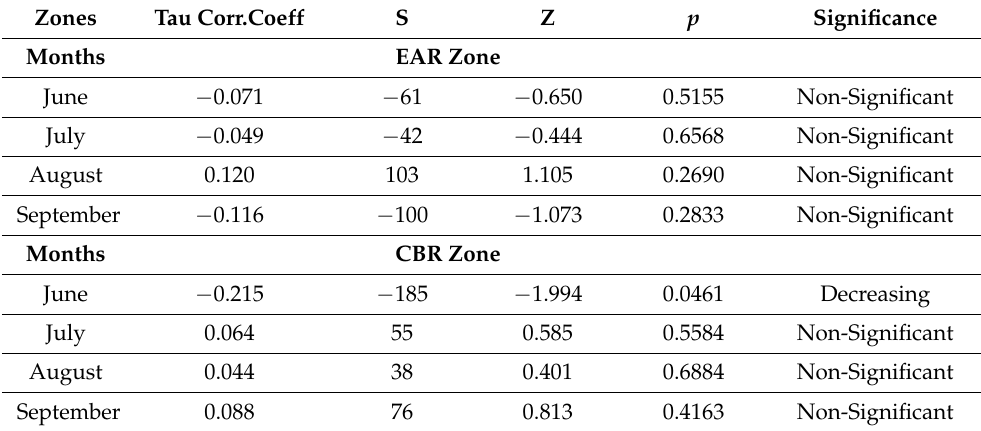
Table 5. Mann Kendall Trend Test of OLR in W/m 2 for Walker zones monthly.